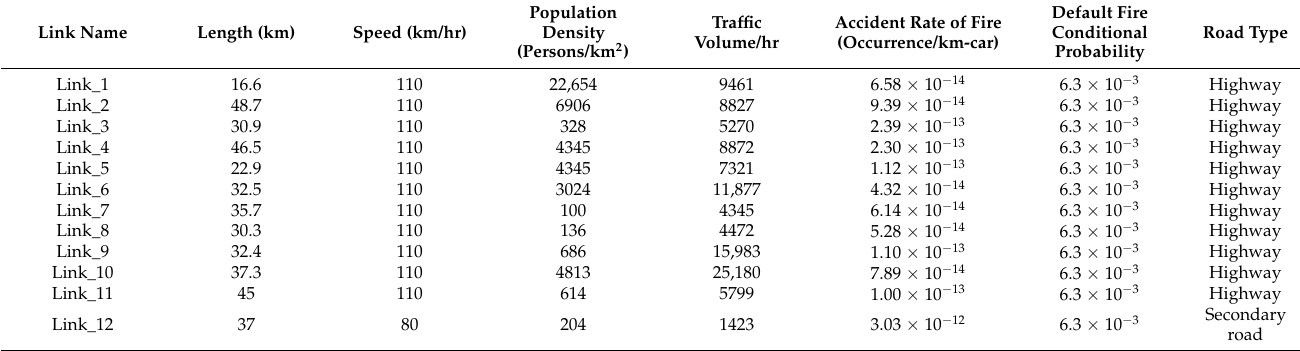
Table 4. Physical input data used in RADTRAN code for assessment of population/collective dose and risk [29,32,33].